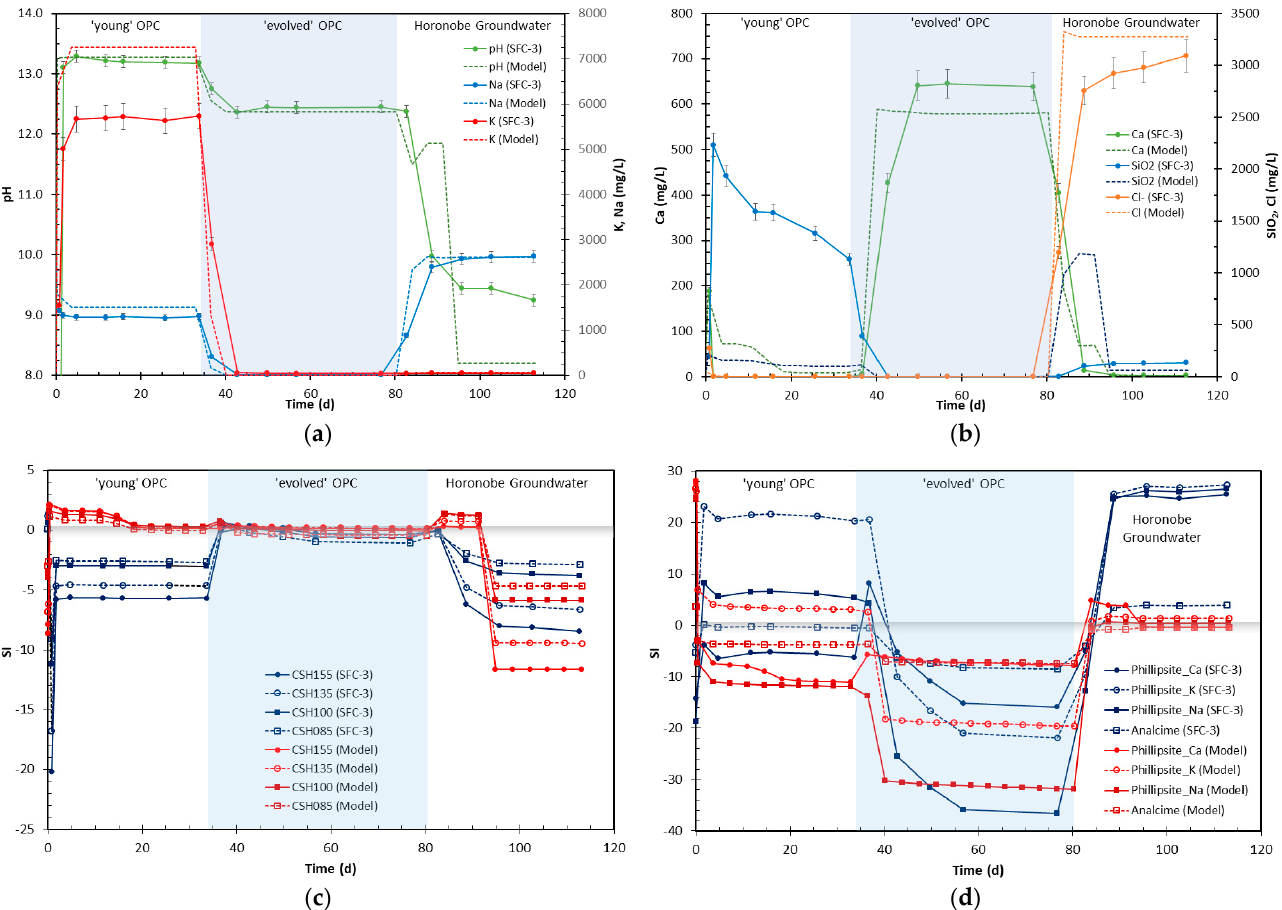
Figure 9. Summary of the model predictions compared with the experiment data ( a ) pH, [Na], and [K]; ( b ) [Ca], [SiO 2 ], and [Cl]; ( c ) selected C-S-H saturation indices; ( d ) zeolite saturation indices.